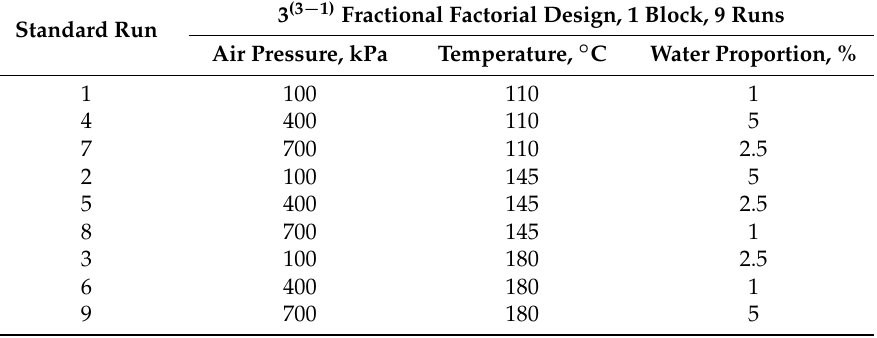
Table 2. Experimental design 3 3 − 1